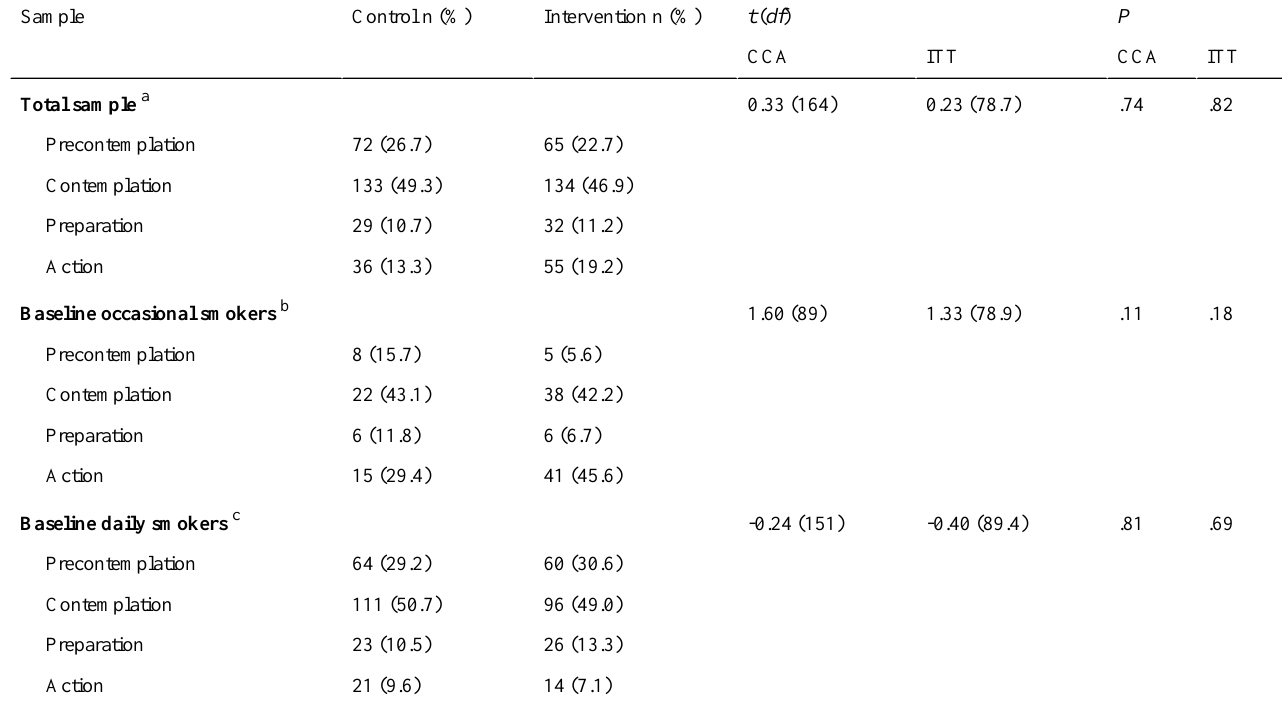
Table 4. Stage of change at follow-up based on complete case data and results of ordinal regression analyses comparing stage of change between the study groups using complete-case analyses (CCA) and intention-to-treat analyses